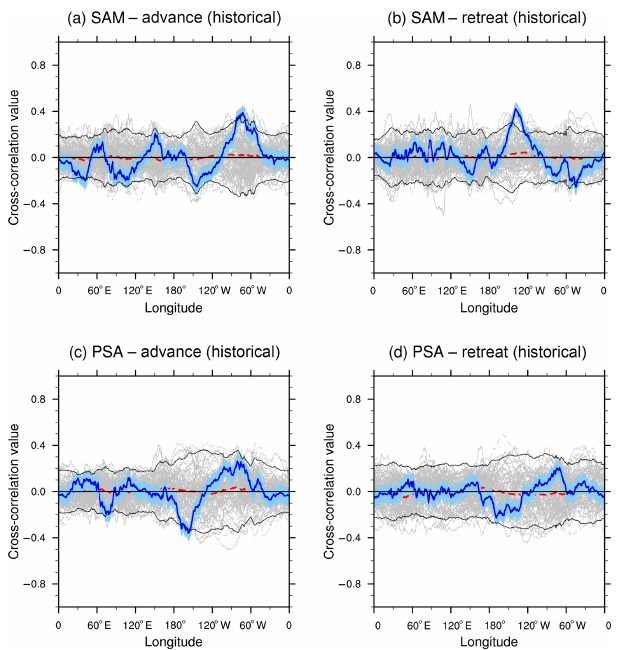
Figure 7. Cross-correlation of SIE with historical (1979–2005) SAM during (a) advance and (b) retreat, with historical (1979– 2005) PSA during (c) advance and (d) retreat. The blue line in- dicates observation-based correlations, with the light blue shading depicting the 95% confidence interval. The red dotted line shows the multi-model mean, and the pale grey lines show individual model correlations. The thin black lines at the edge of the grey lines shows 1.96 standard deviation from the simulations at each longi- tude point, while the horizontal black line shows the zero line for